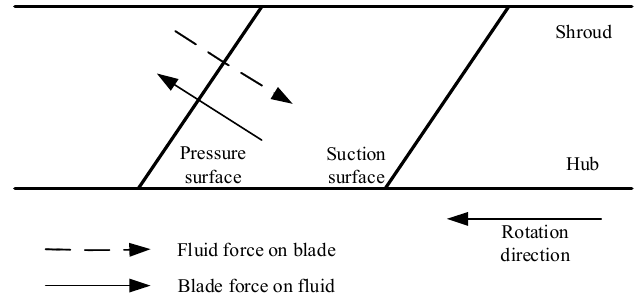
ff ect of blade lean on pressure Figure 2. Effect of blade lean on pressure distribution. Figure 2. E